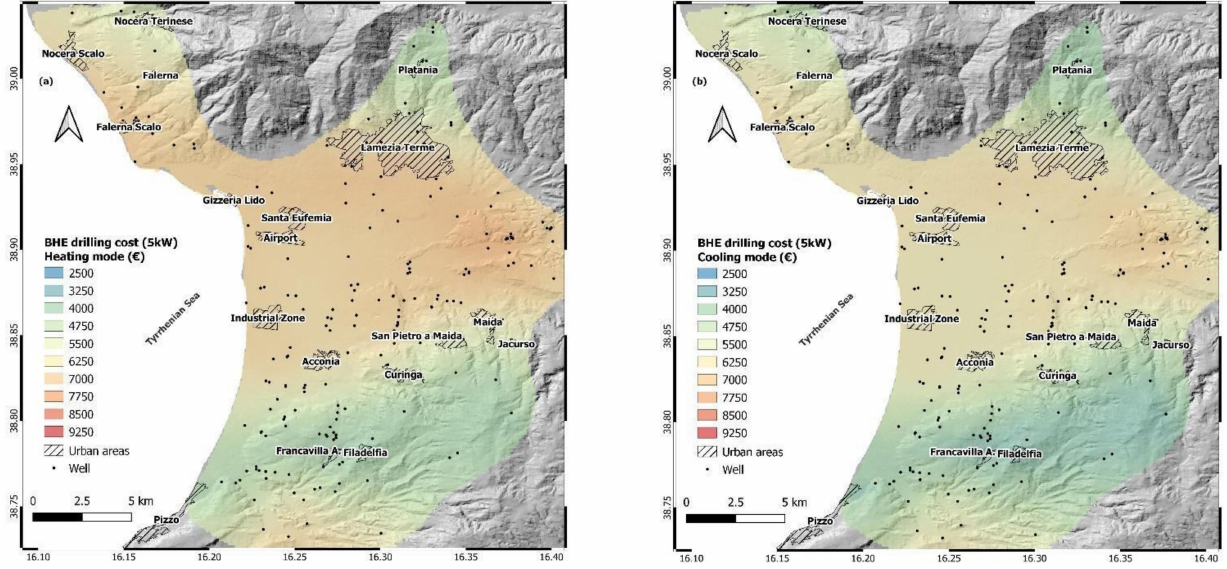
Figure 7. Drilling cost maps for space ( a ) heating and ( b ) cooling. Costs are calculated based on the BHE length